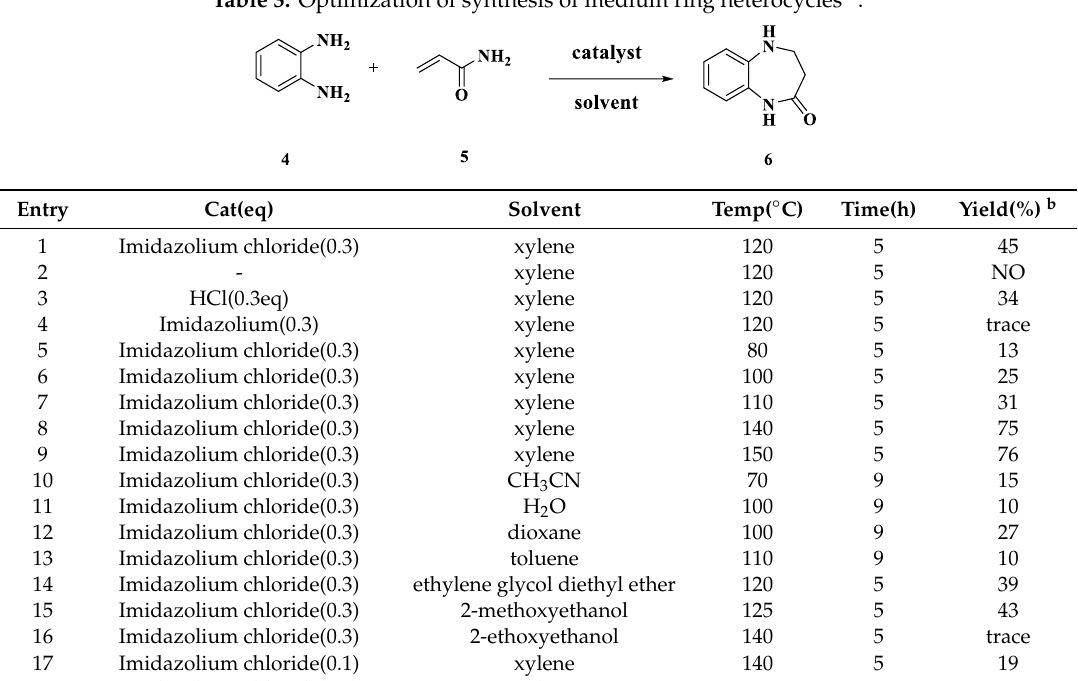
Table 3. Optimization of synthesis of medium ring heterocycles a .